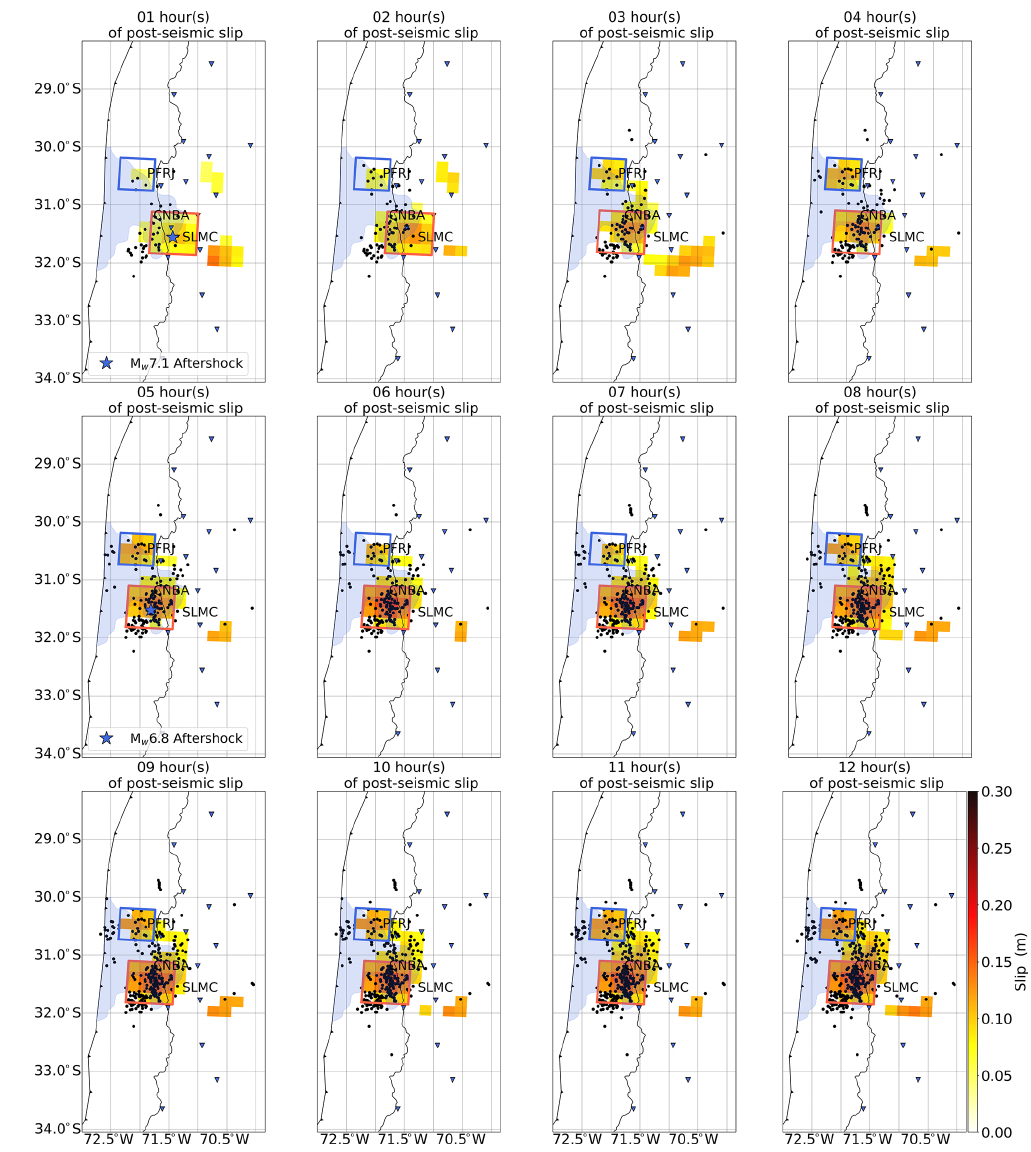
Figure 5. Hourly map of the post-seismic slip distribution over the first 12h after the mainshock along with the cumulative aftershocks from the catalog compiled by Huang et al. (2017) and shown with black dots. Detailed caption can be found in Fig. 3.